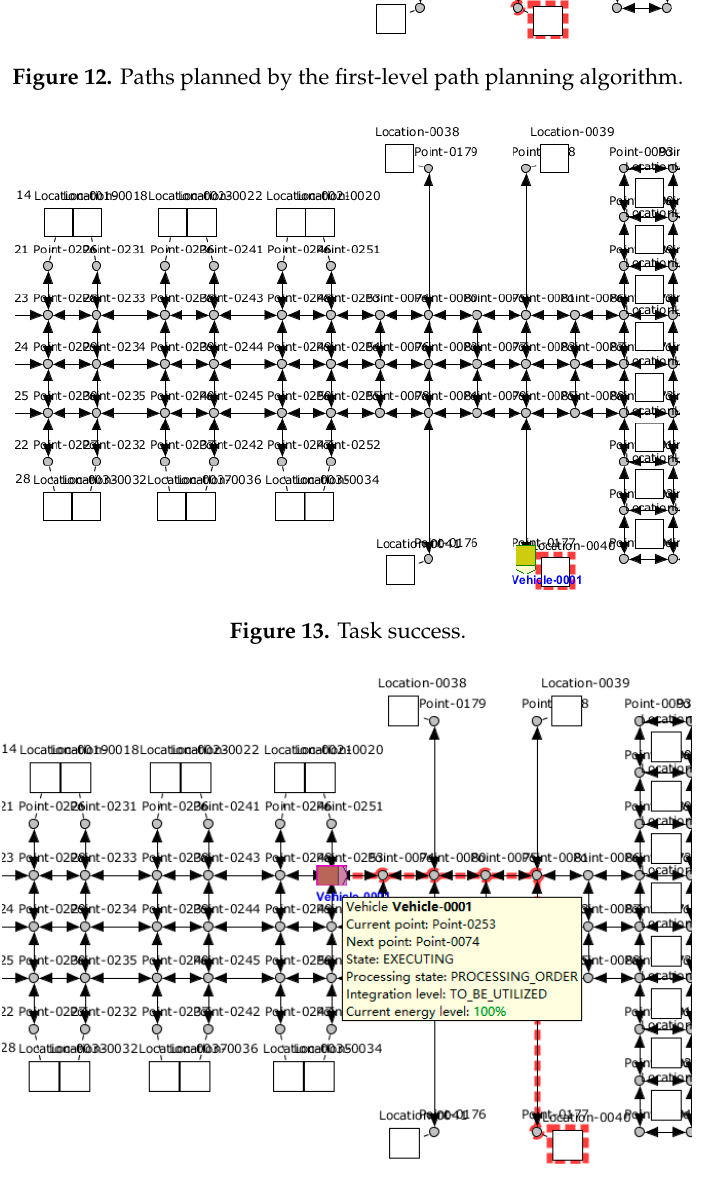
Figure 15. Multi-AGV loading. The proposed algorithm completed the task. The path of the AGV performing tasks is shown in Figure 16. It can be seen that the first level path planning algorithm planned the shortest path for each AGV. When a conflict occurs, the AGV successfully bypasses and completes the task through the second-level path planning algorithm. The proposed bi-level path planning algorithm selects the optimal path in path planning and can solve path conflicts effectively.